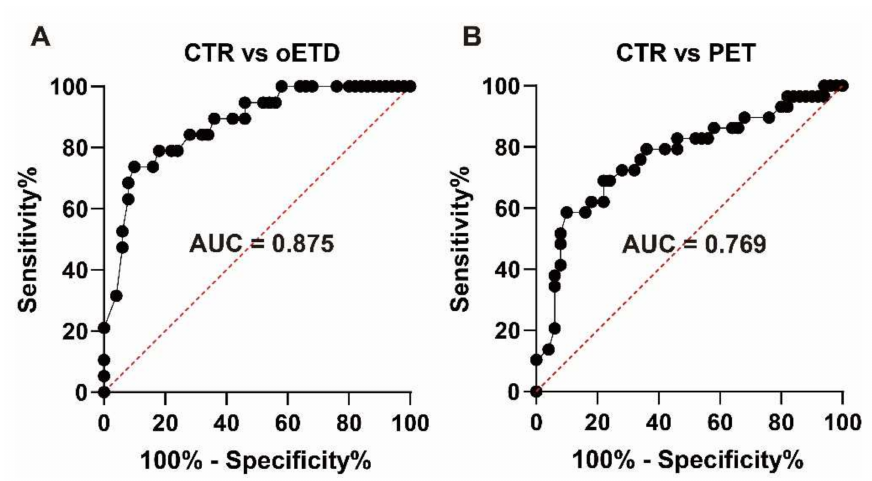
Figure 2. Receiver operating characteristics curve analysis. ( A ) For diagnosing oETD, ( B ) for diag- nosing PET. AUC: Area under the curve, CTR: Control group, oETD: obstructive Eustachian tube dysfunction group, PET: patulous Eustachian tube dysfunction group. Table 2. Diagnostic values of the modified nine-step test.